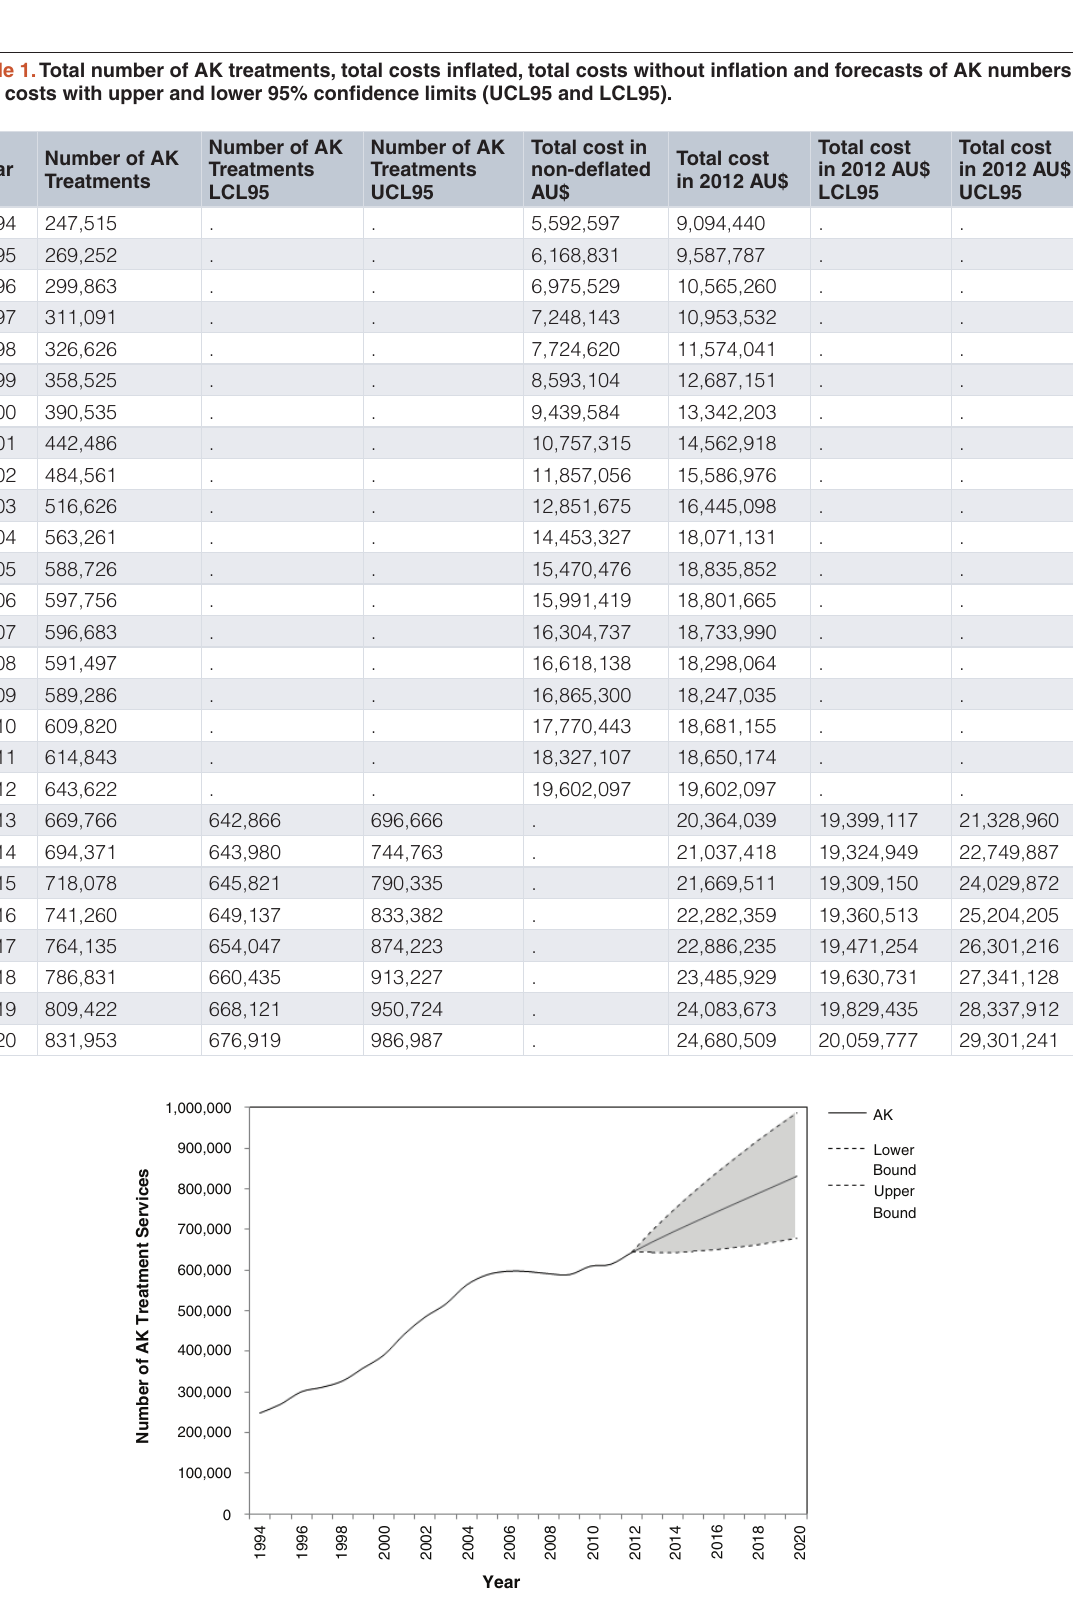
Figure 1. Total number of AK treatments from 1994–2020. Estimated treatment numbers from the period of 1994–2020. Estimated treatment numbers with 95% CI from 2013–2020 is shaded in